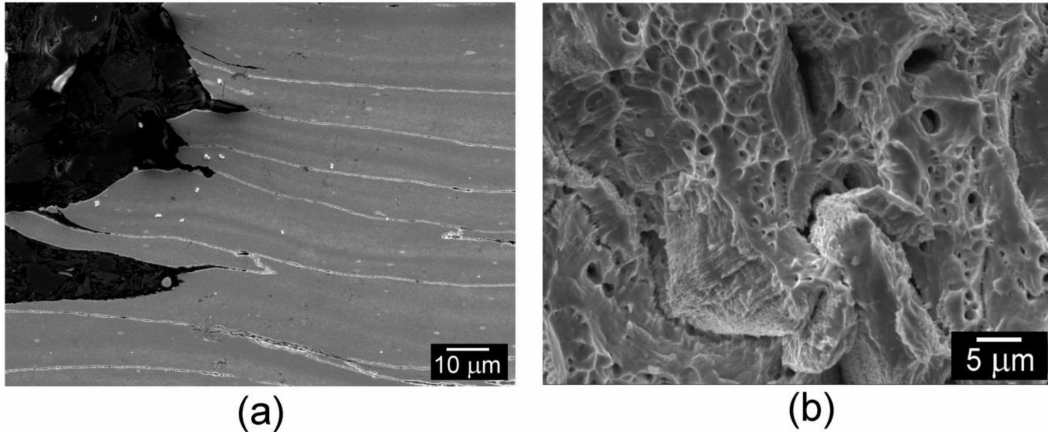
Figure 12. Fracture analysis of the failure in TP316H steel region after room-temperature tensile test of T92/TP316H dissimilar weldment in “QT PWHT” condition: Fracture path and microstructure beneath the failure ( a ); Fracture surface with tear ridges and dimple areas ( b